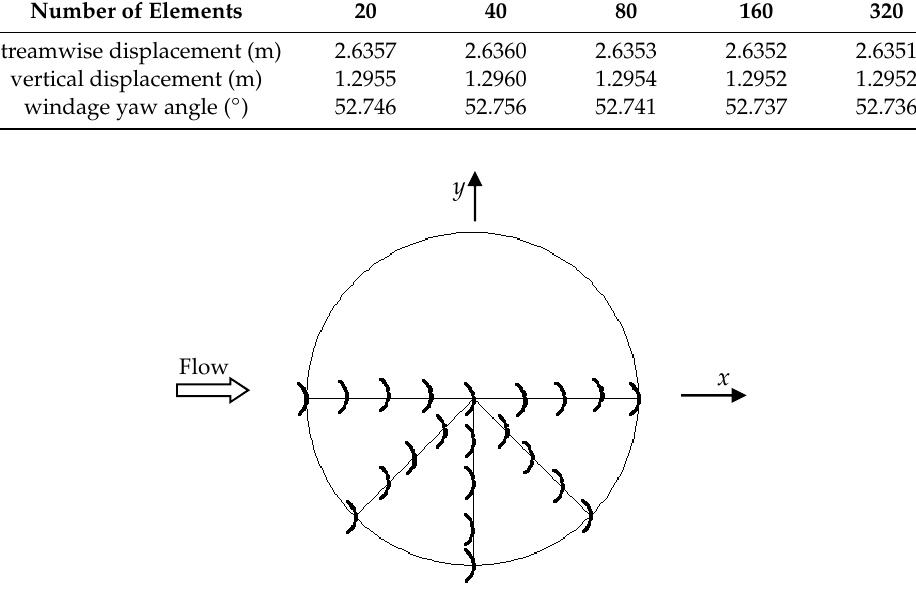
Table 2. The wind-induced response with di ff erent number of elements. Table 2. The wind ‐ induced response with different number of elements. Table 2. The wind ‐ induced response with different number of elements.